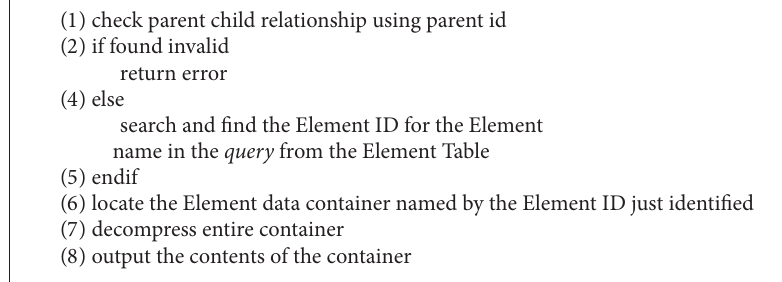
Algorithm 4: Complete set query.